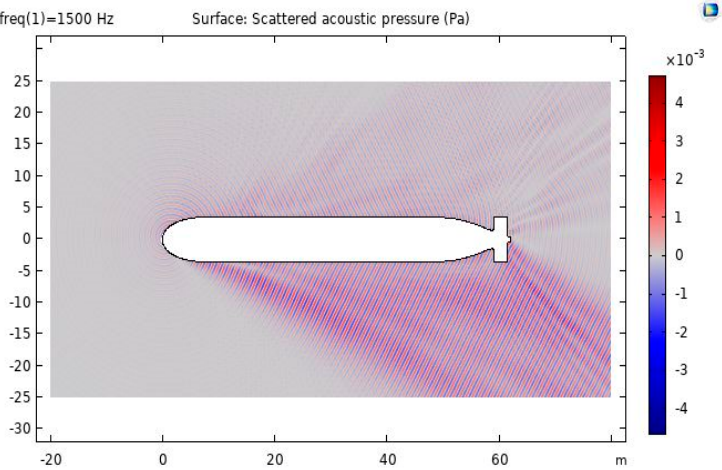
Figure 6. Cross-section of the distributed acoustic pressure. Inventions 2022 , 7 , x FOR PEER REVIEW